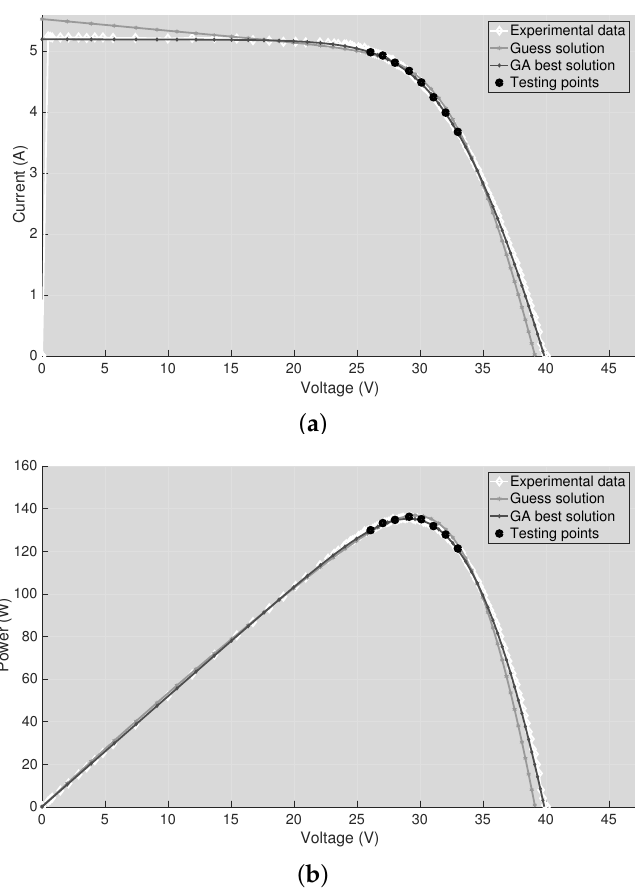
Figure 6. Comparison of the I-V and P-V photovoltaic curves for Test #1. ( a ) Photovoltaic I-V curves; ( b ) photovoltaic P-V